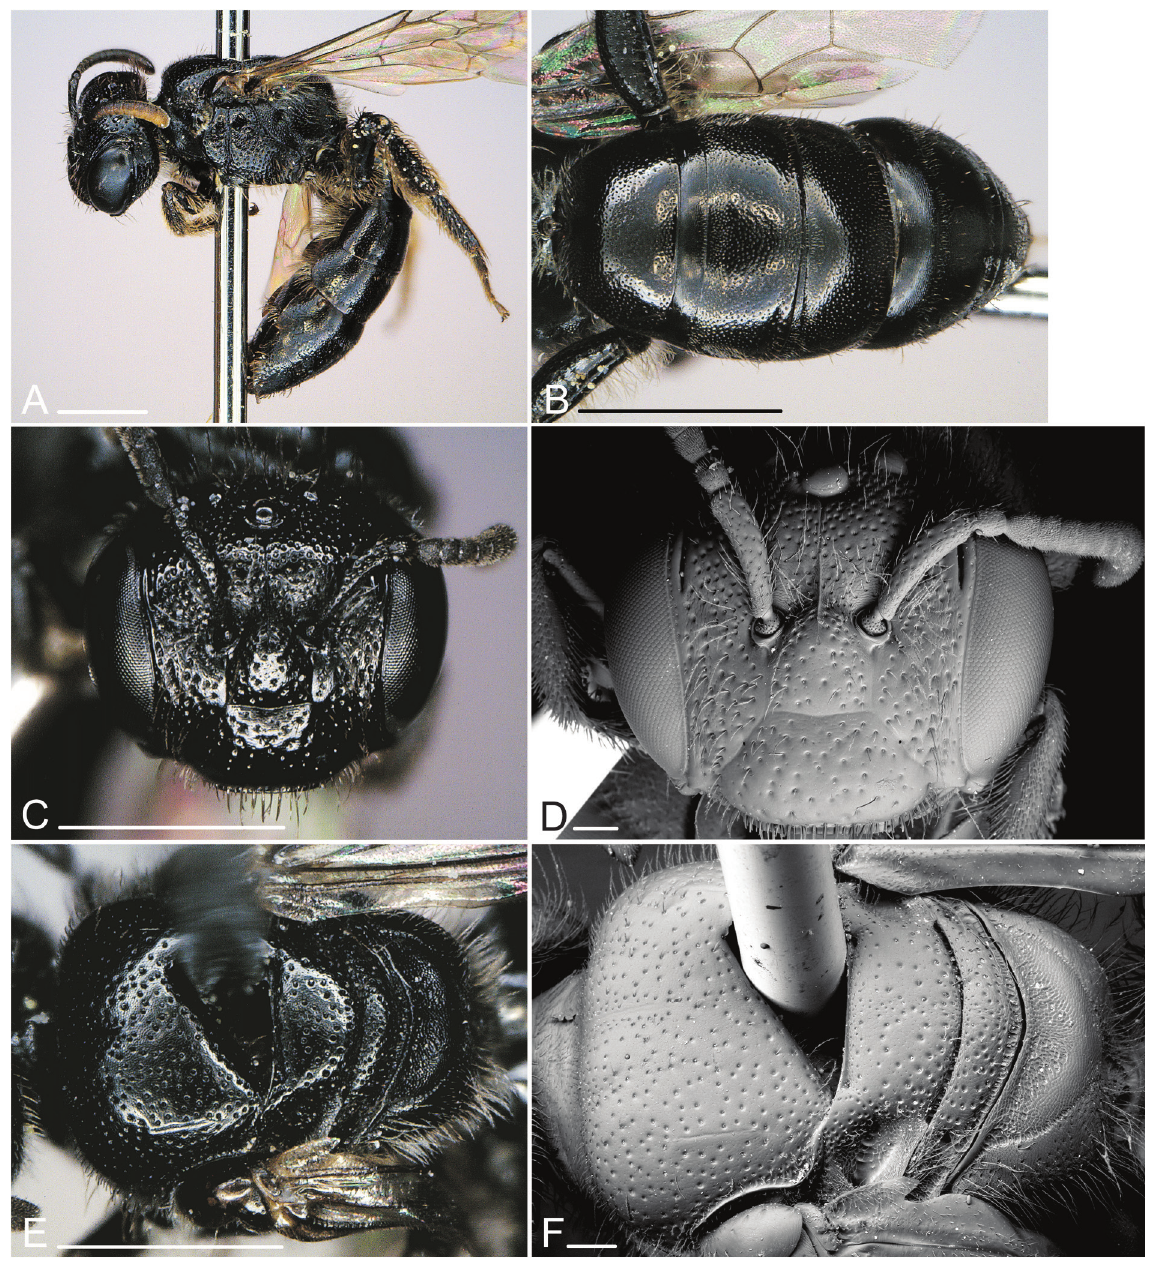
Fig. 18. Scrapter nigerrimus sp. nov., ♀. A . Lateral view. B . Metasoma (dorsal view). C . Head. D . Head (SEM). E . Thorax (dorsal view). F . Thorax (dorsal view, SEM). Scale bars: photos: 1 mm, SEM: 0.1